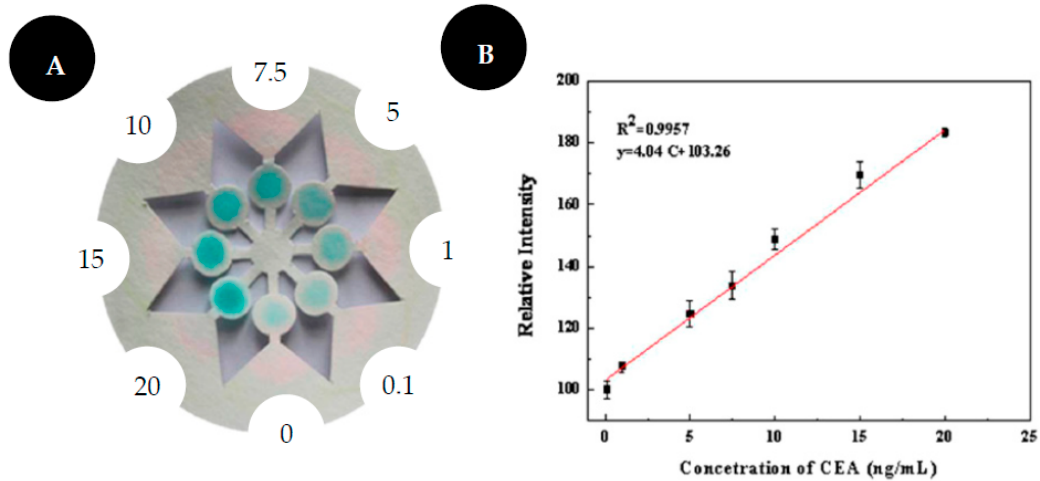
Figure 5. Scheme of ring-over device for CEA detection ( A ). Results of CEA detection ( B ). Reproduced and adapted with permission from [38].